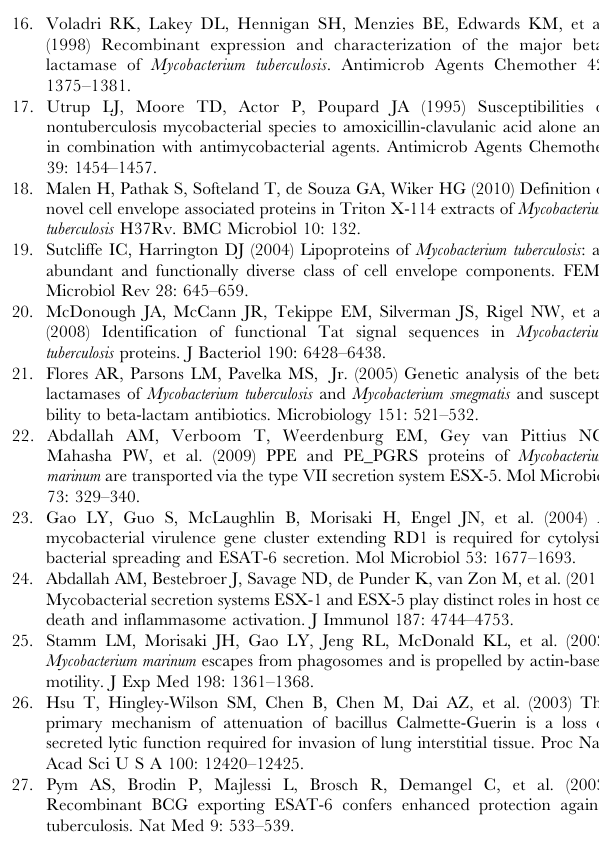
Figure S6 Evaluation of cell death in THP-1 cells by cytofluorometry. Cytofluorometry analysis of THP-1 cells infected with wild-type M. tuberculosis and BCG strains at day 5 post-infection. THP-1 cells were stained with 7-AAD (BD Pharmingen) (necrosis). Figure S7 Apoptosis and necrosis do not influence the cleavage of the CCF-4 probe in THP-1 macrophages. THP-1 cells were subjected to different treatments for 18 h in order to induce either apoptosis or necrosis. Apoptosis was induced using 4 m M staurosporine, 5 m g/ml cycloheximide or 200 ng/ml TNF- a . Necrosis was induced using 0.1% H 2 O 2 , 100 m g/ml concanavalin A or cycloheximide/TNF- a combina- tion. Cells were then loaded with the CCF-4 probe for 2 h. After